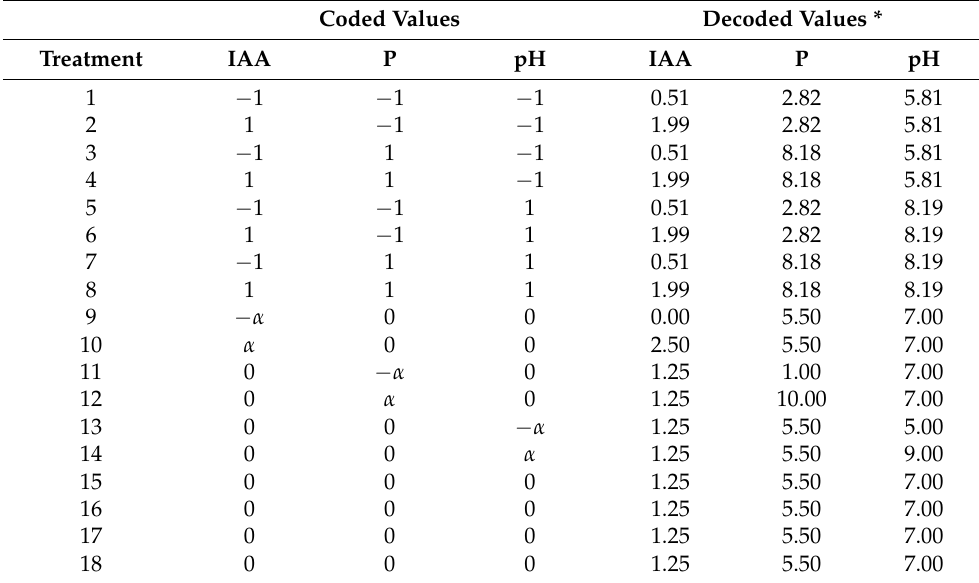
Table 4. Treatments generated for the central composite